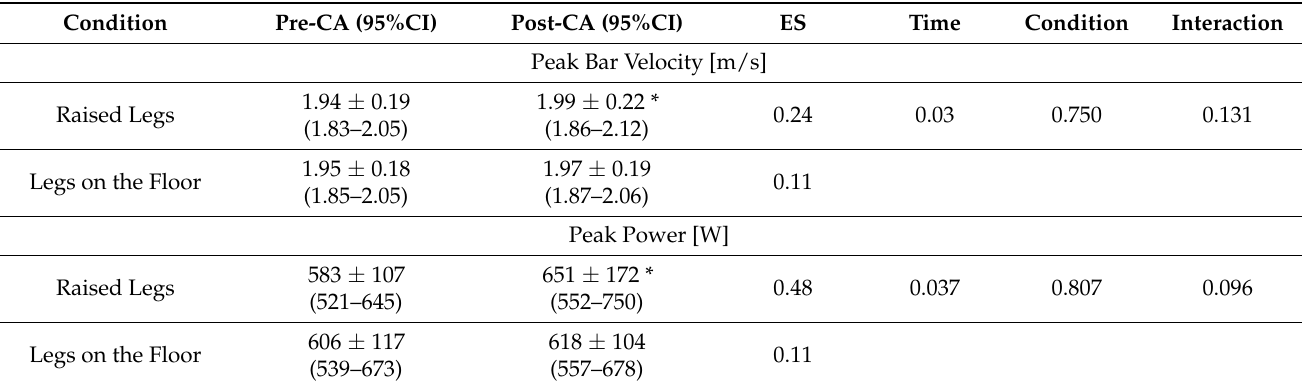
Table 2. Differences in peak velocity and peak power output during bench press with legs raised and on the